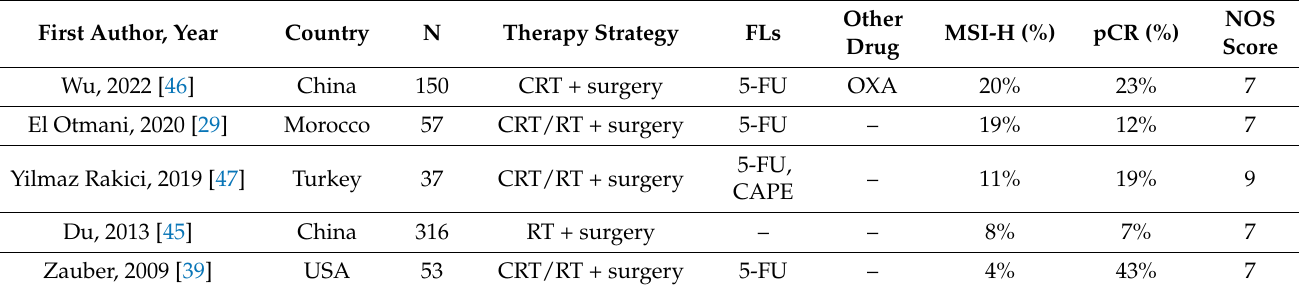
Table 3. Main characteristics of included studies for microsatellite instability (MSI)